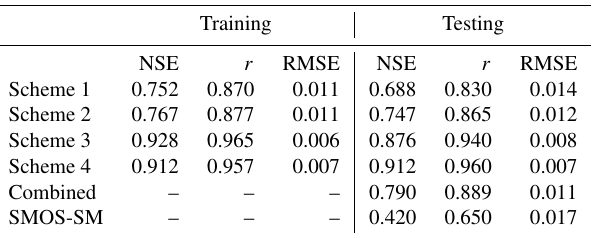
Table 5. Summary of SMD estimation performances. It is noted that RMSE is in the unit of metres. Training